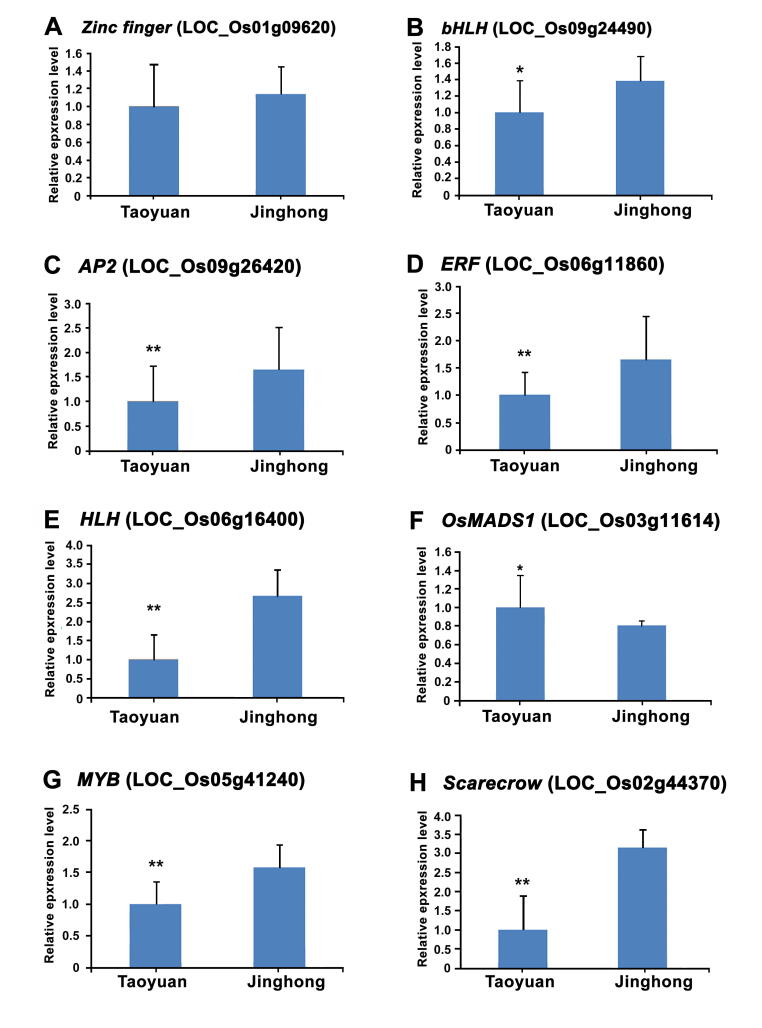
Quantitative RT-PCR validation of eight candidate high-yield-associated genes in the young panicles of rice variety 9311. The differentially expression patterns of zine finger (LOC_Os01g09620) (A), bHLH (LOC_Os09g24490) (B), AP2 (LOC_Os09g26420) (C), ERF (LOC_Os06g11860) (D), HLH (LOC_Os06g16400) (E), OsMADS1 (LOC_Os03g11614) (F), MYB (LOC_Os05g41240) (G) and scarecrow (LOC_Os02g44370) (H). The asterisks indicate significant differences in the gene expression levels between Taoyuan and Jinghong as determined by Student’s t-test (*, P < 0.05; **, P < 0.01).